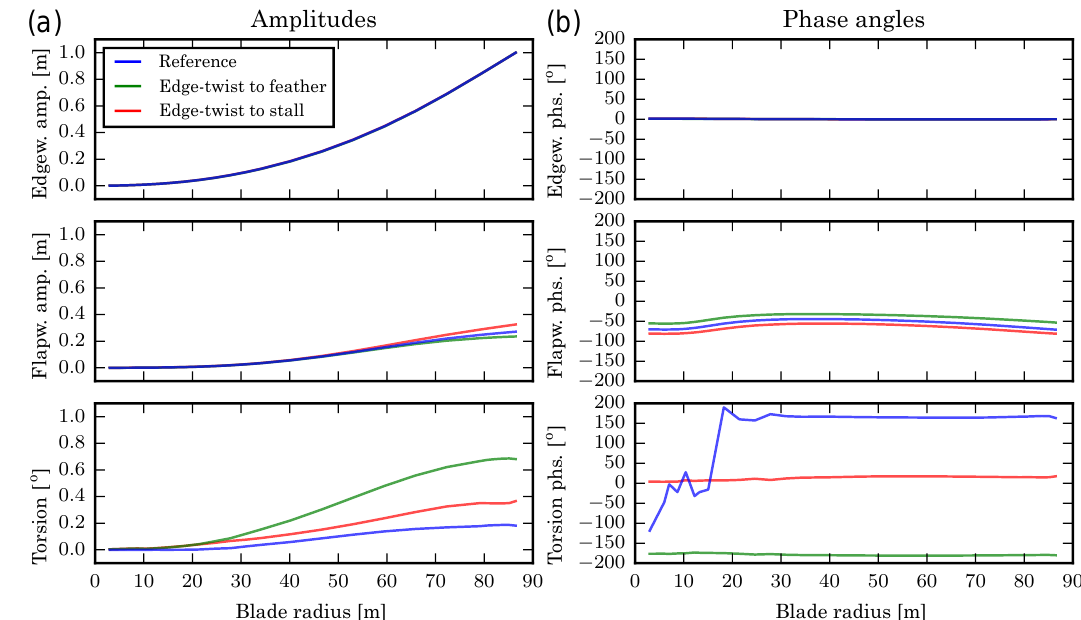
Figure 12. Amplitudes (a) and phase angles (b) of the first aeroelastic edgewise mode at 8ms − 1 wind speed for the reference (blue), and edge–twist to feather (green) and stall (red) coupled DTU 10MW RWT blades. Coupling coefficients are γ x = ± 0 . 1 constant along the blade. Amplitudes are normalized to 1.0 m tip deflection in the edgewise direction, and phase angles are relative to the edgewise tip deflection.